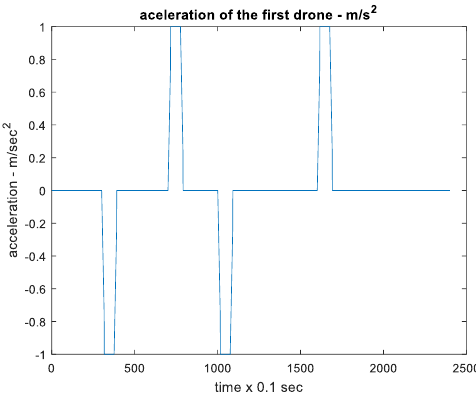
Fig. 2. The acceleration of the leading drone.